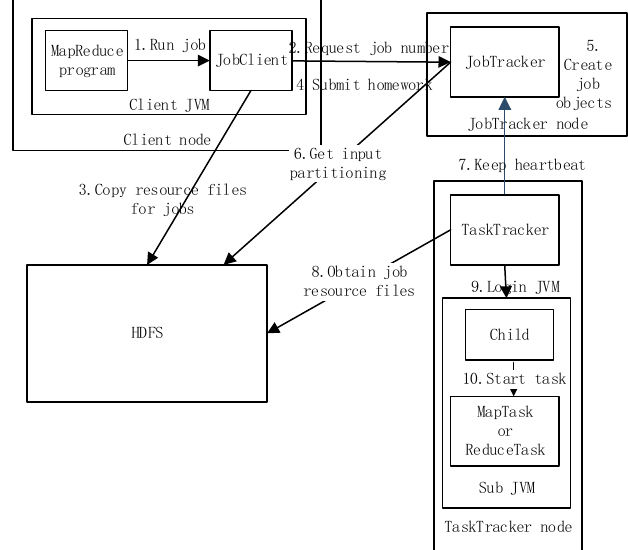
Figure 1. MapReduce